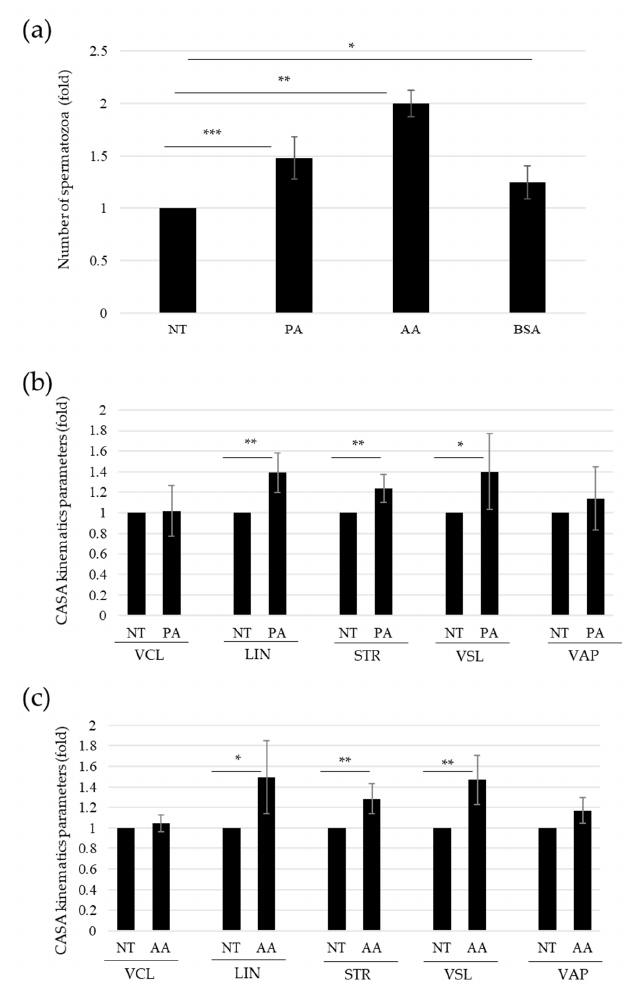
migrated spermatozoa in both the PA- and AA-treated samples compared to the control to a greater extent than the BSA treatment (Figure 3a).